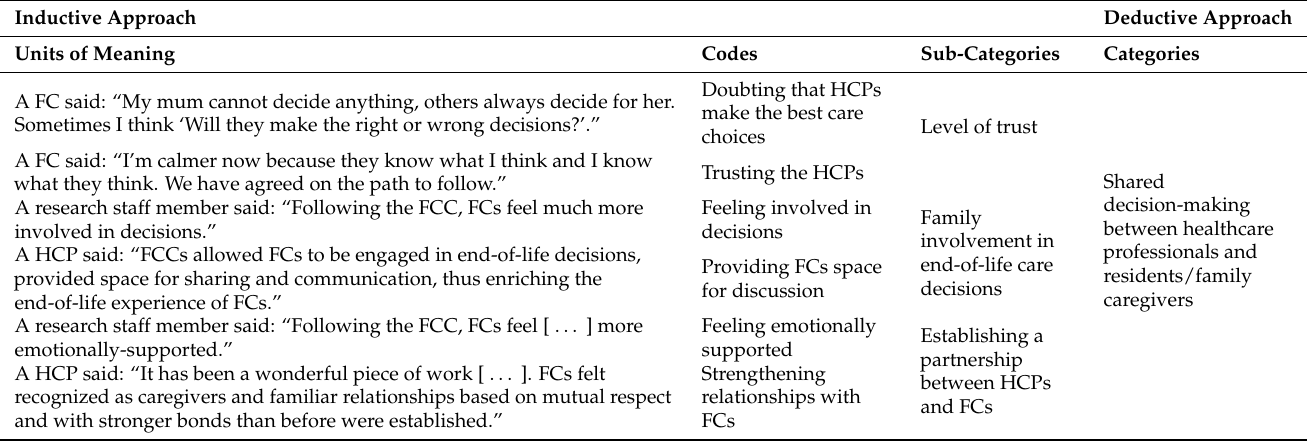
Table 3. Analytical Process Performed: an